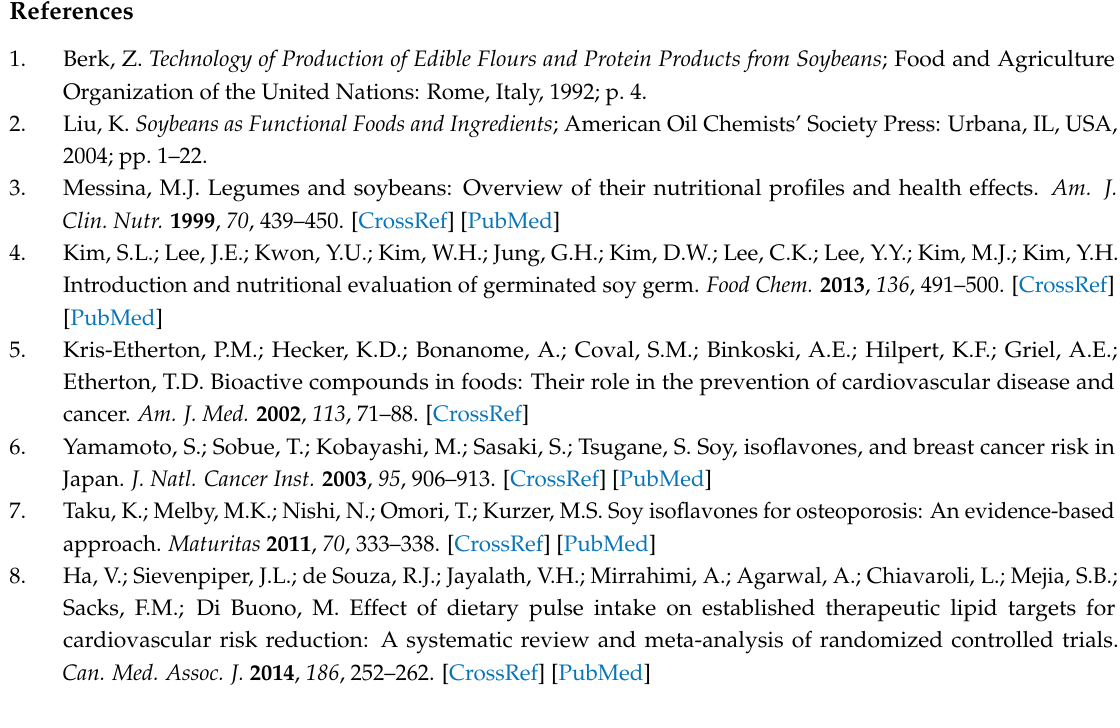
Supplementary Materials: Change of composition and content of phenolic compounds of RSF at room and high temperature, MRM ion chromatogram of standards, MS/MS spectra of phenolic acids and isoflavones are available